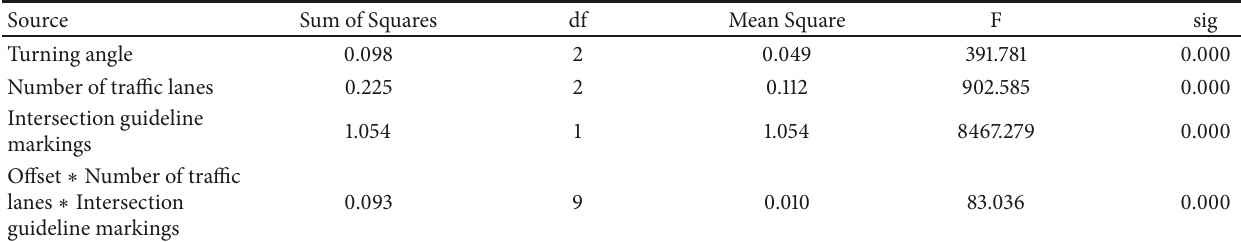
Table 5: Multifactor analysis of variance for left-turns.